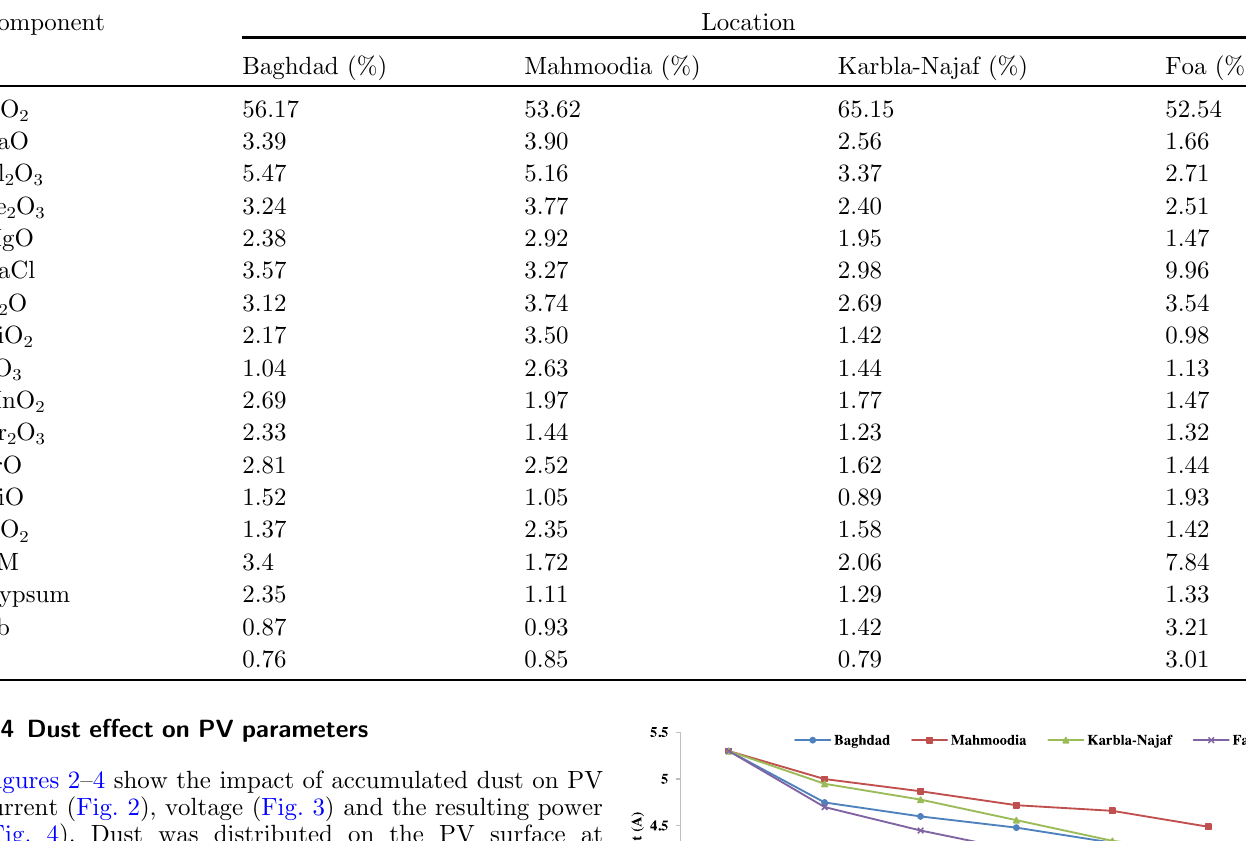
Table 3. Dust components in the studied samples. Component